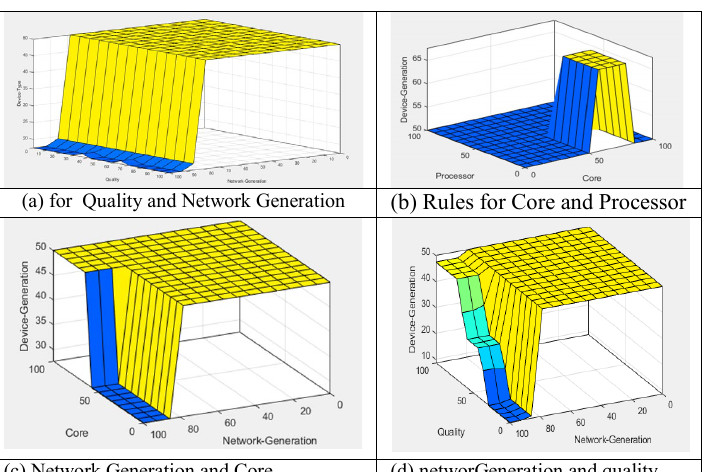
Figure 6. Proposed HKCFIS Model Lookup Diagram for Not Smart Mobile Phone Table 2. Proposed HKCFIS Device-Generation Surface Views w.r.t various input